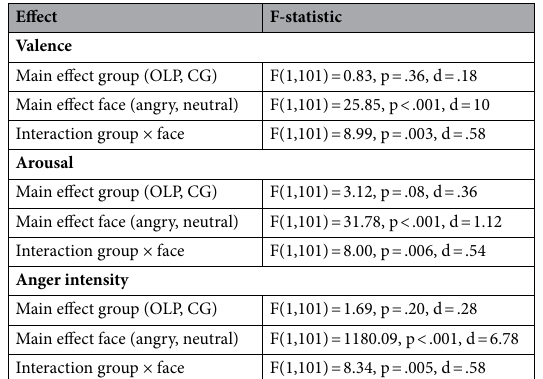
Table 1. Results of the mixed-factorial analyses of variance for self-reports of valence, arousal, and perceived anger intensity by the open-label placebo (OLP) group and the control group